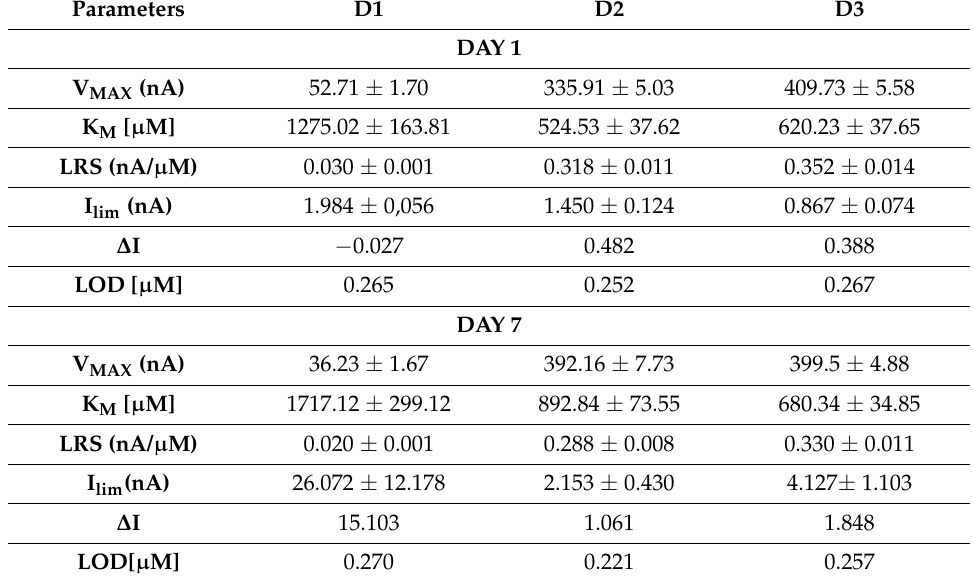
In vitro characterization of three different biosensor designs at Day 1 and day 7 in terms of Michaelis–Menten kinetic parameters (V MAX and K M ) and analytical parameters (Linear Region Slope –LRS, and LOD) for each